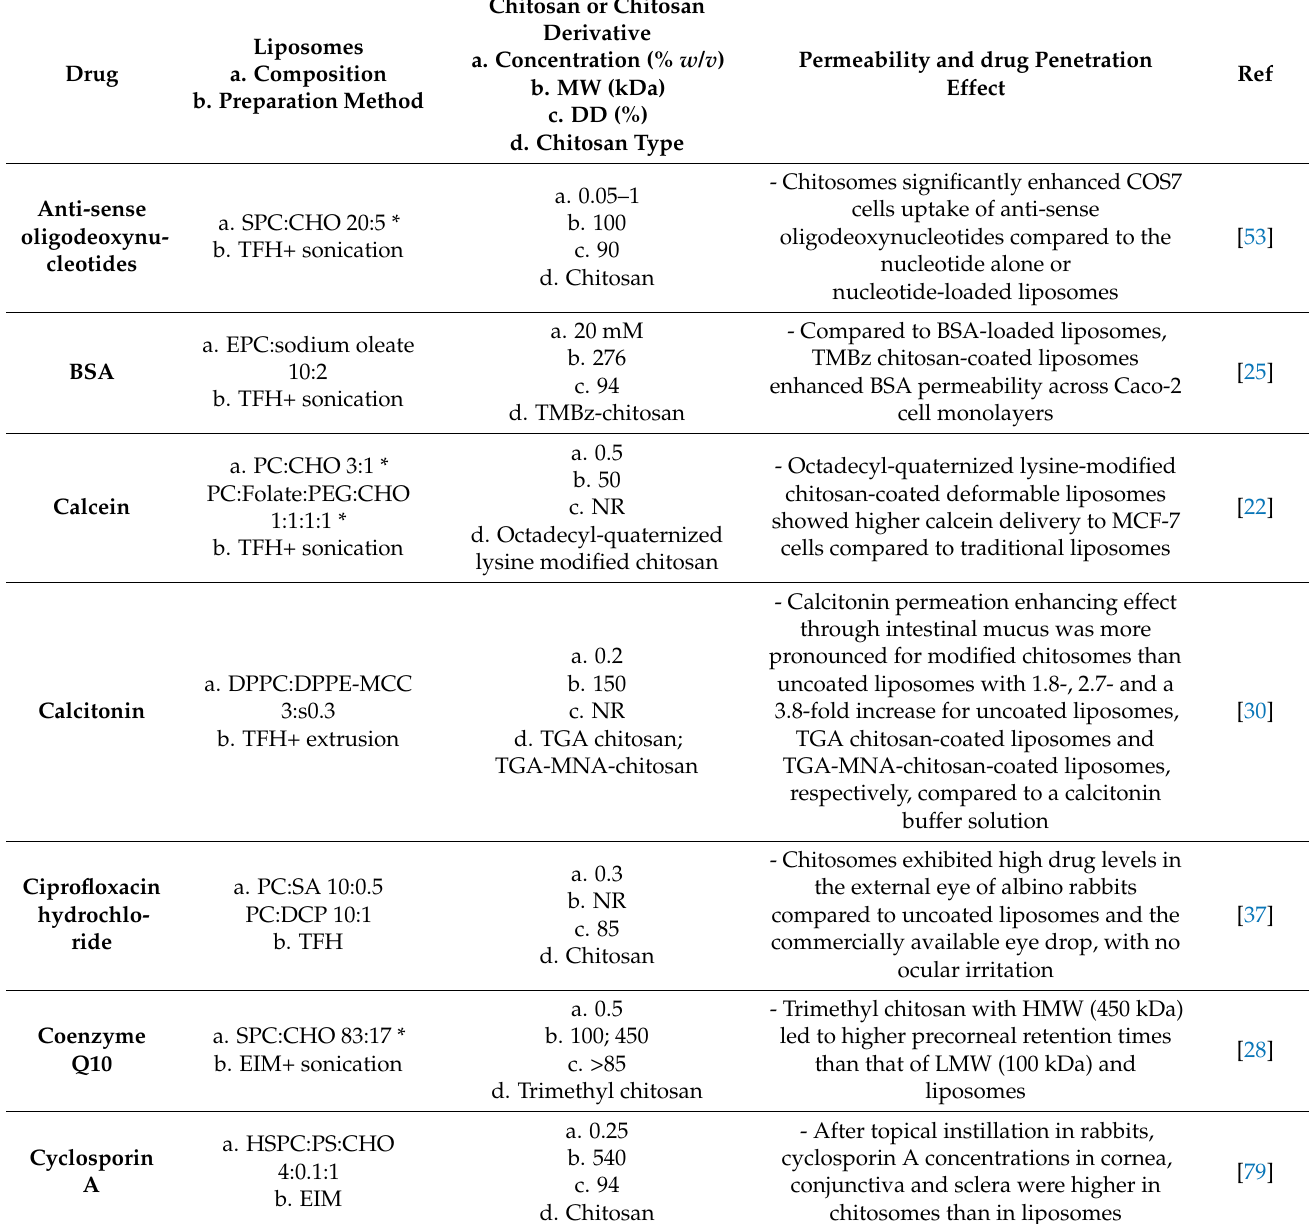
Table 10. Permeability and drug penetration studies: conventional liposomes and chitosomes. The liposomal composition is indicated in the table in molar ratio except when * exists, indicating a weight ratio ( w/w ).